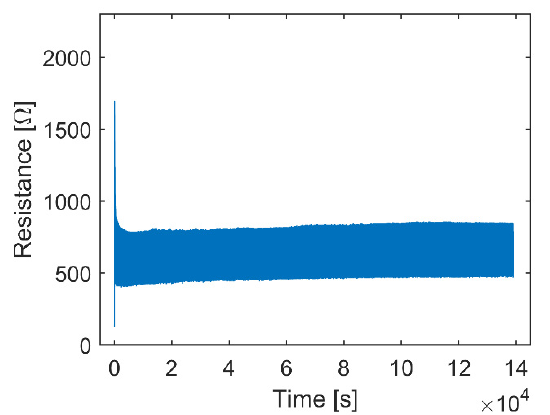
Figure 5. Raw data of a sample from the sample series with two thin CFCs, elongated 50% 10,000 times. The data show the high increase in resistance in the first cycle and the decrease in resistance and stabilization that occurred within a few cycles.